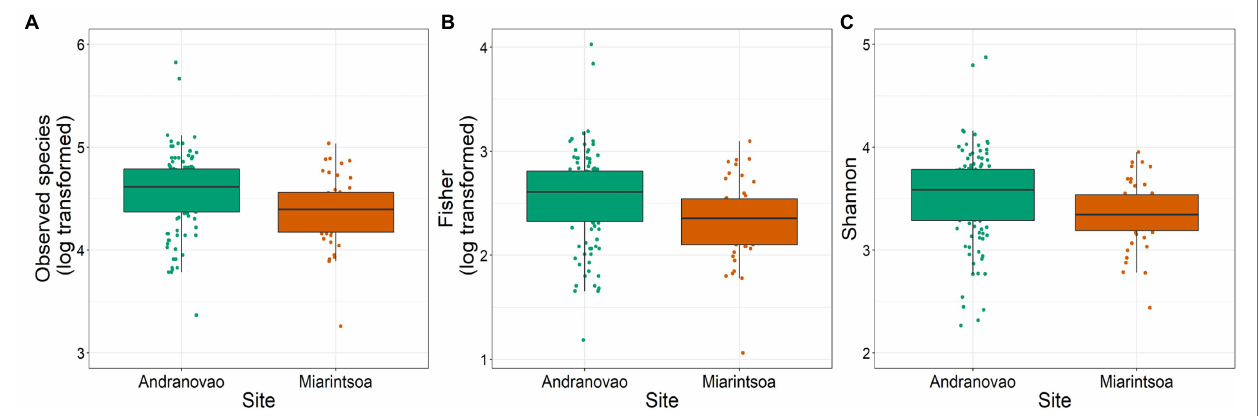
FIGURE 2 | Alpha diversity of gut bacteria in gray-brown mouse lemurs differs between habitats. Effect of study site on (A) number of observed species, (B) Fisher diversity index, and (C) Shannon diversity index of mouse lemur individuals. Individuals from Miarintsoa (red) revealed a lower bacterial diversity than individuals trapped in Andranovao (green; see Supplementary Table S1 for details).